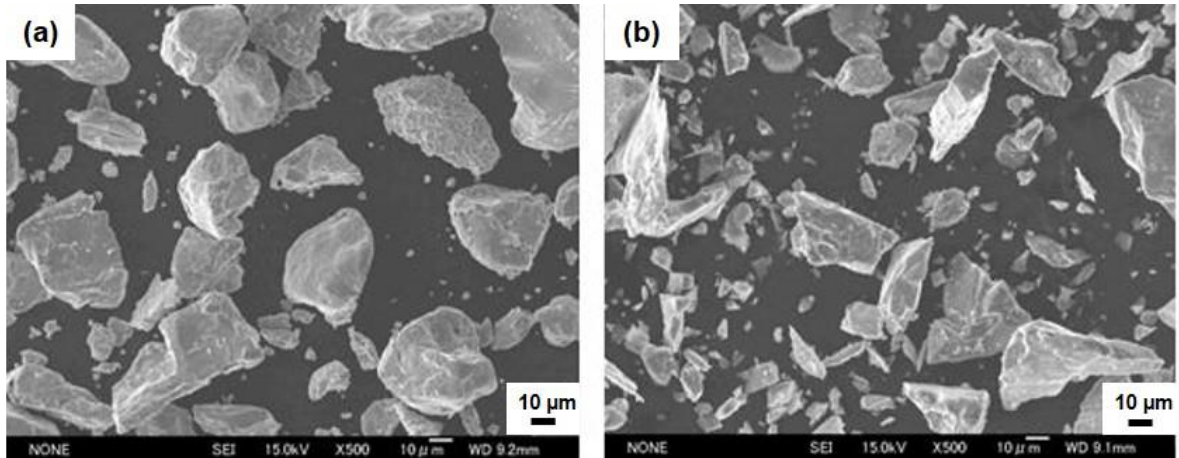
Figure 2. SEM images of original Cr ( a ) and Si ( b )